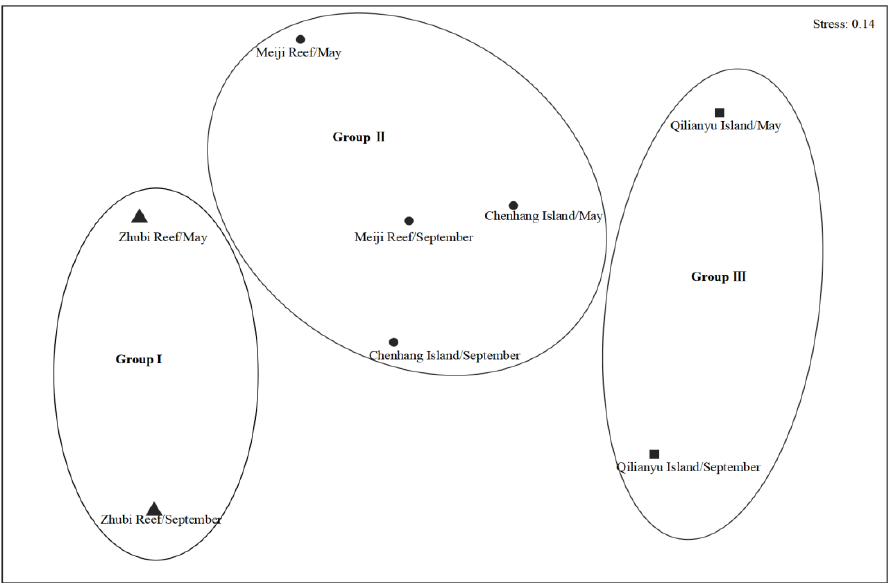
Figure 4. Ordination of non-metric multidimensional scaling (NMDS) among fish communities at Meiji Reef, Zhubi Reef, Qilianyu Island and Chenhang Island in May and September.